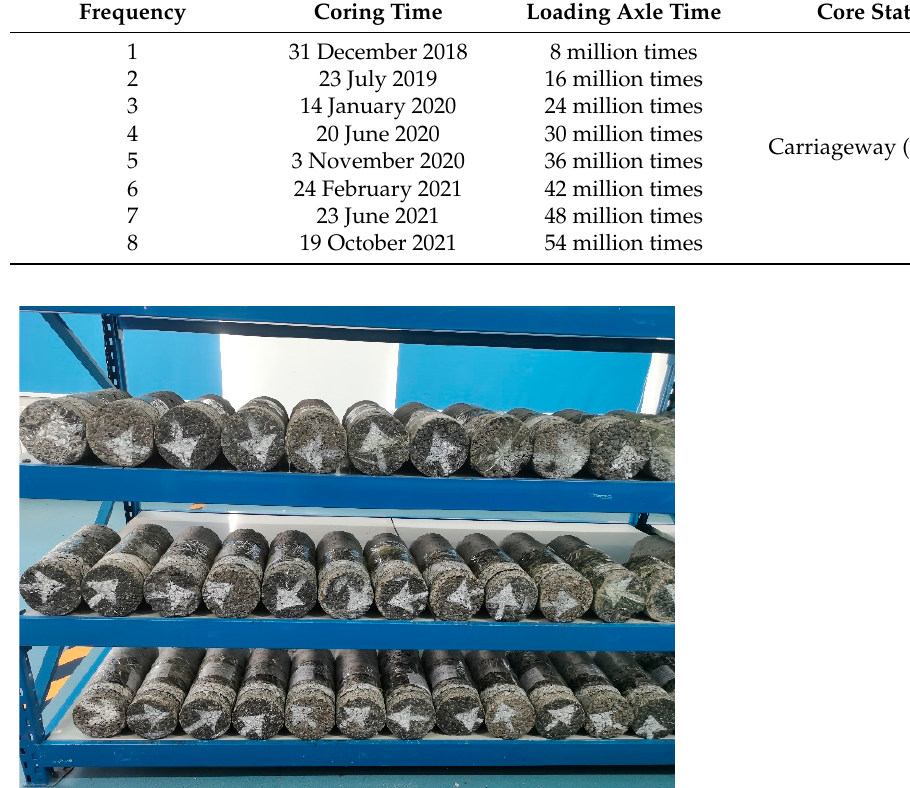
Figure 1. Pavement core sample.